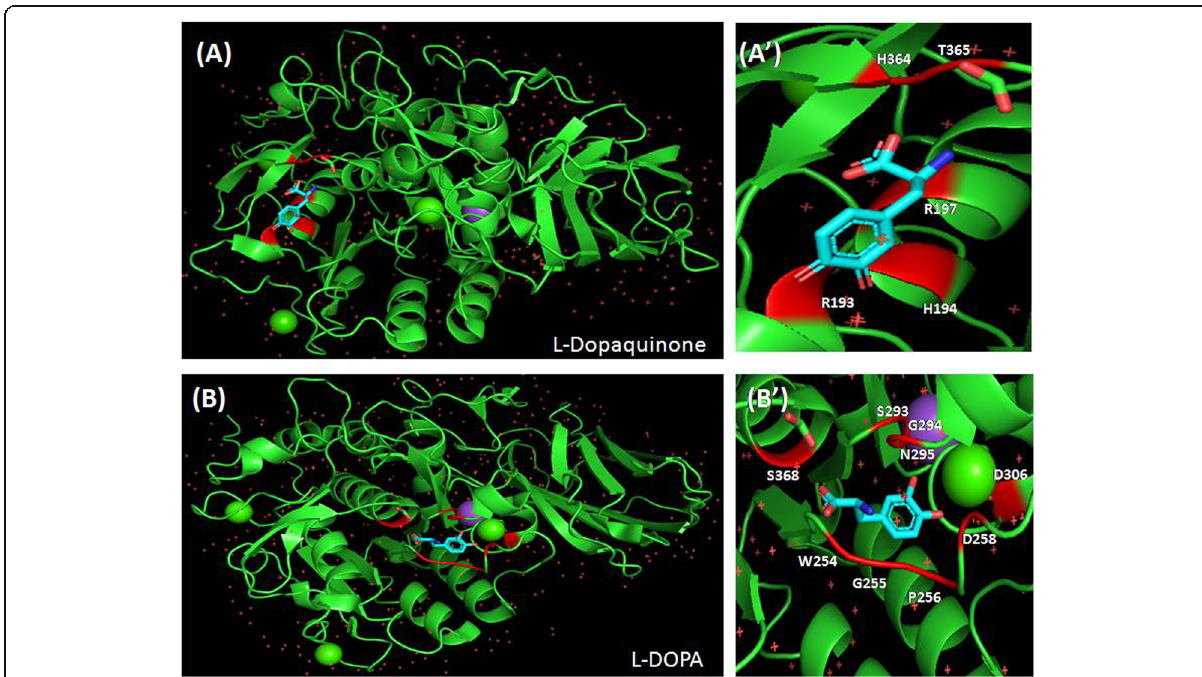
Fig. 5 Docked image ofHuman Furin (PDB ID: 4RYD) with L-Dopaquinone viewed in in PyMO ( A ). Zoomed image of ligand binding site of Furin- L-Dopaquinone complex ( A ’ ).Docked image of human Furin (PDB ID: 4RYD) with L-DOPA viewed in in PyMO ( B ). Zoomed image of ligand binding site of Furin-L-DOPA complex ( B ’ )